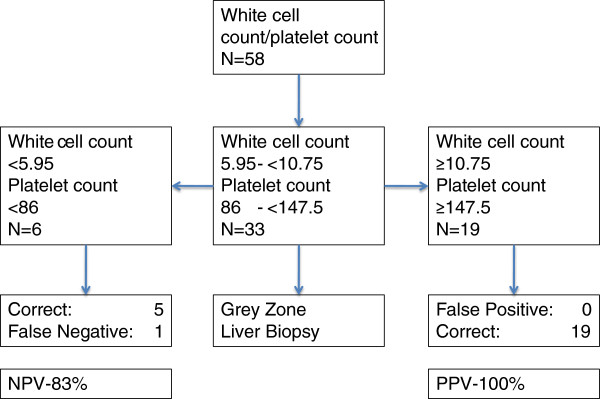
Prediction of alcoholic hepatitis by white cell count and platelet count.